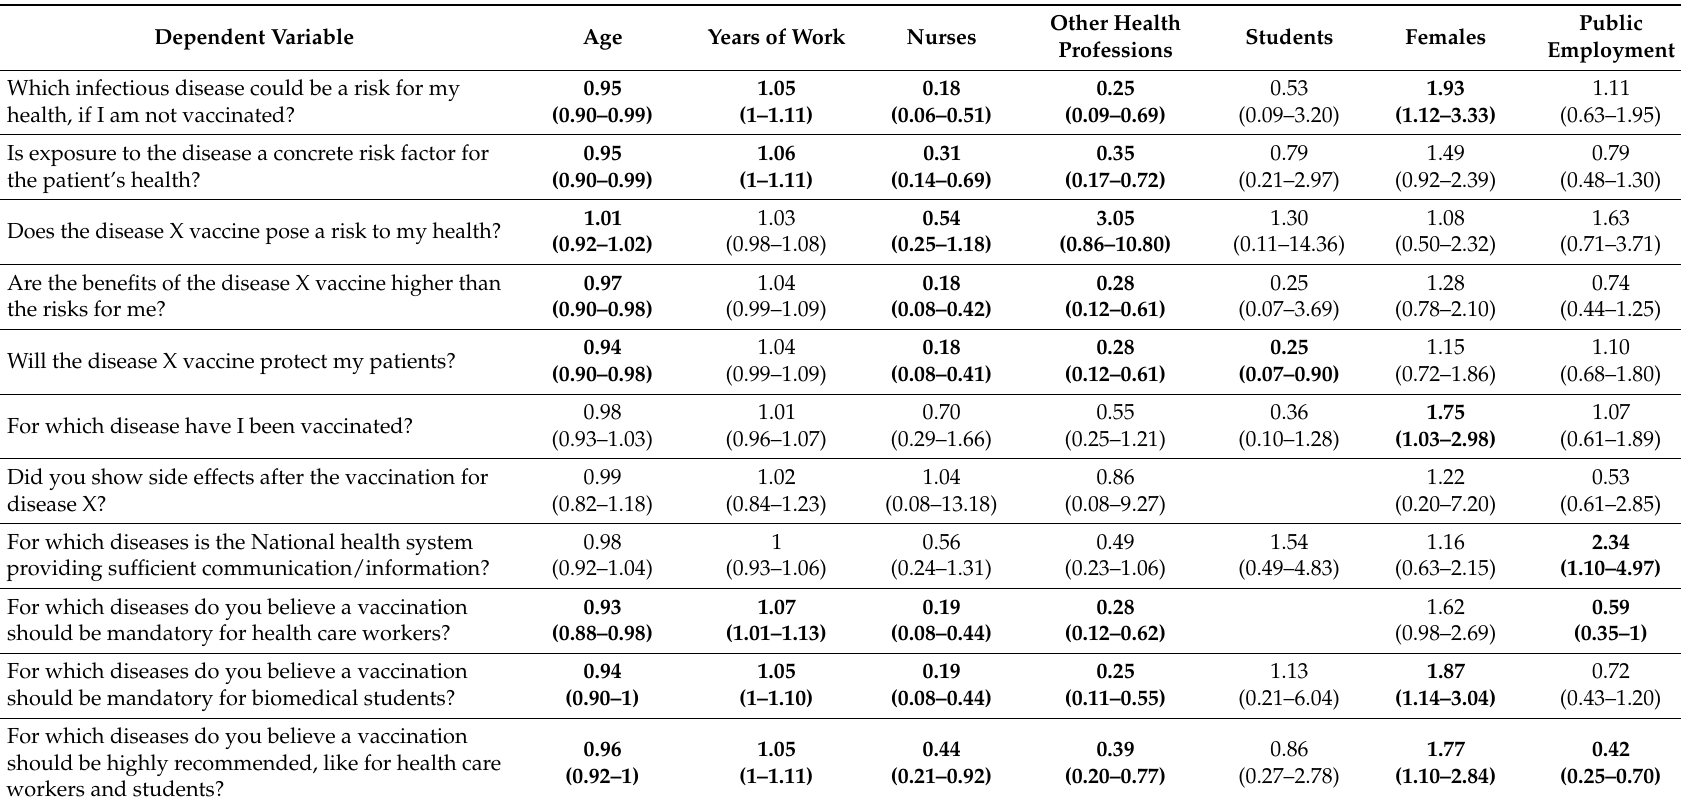
Table 2. Results of the multivariate analysis considering Hepatitis